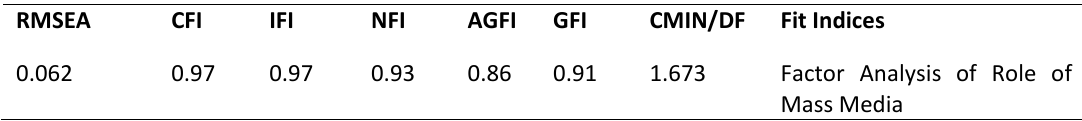
Table 4. Fit Indices of Measurement Model for Level of Influence of Mass Media on Academic